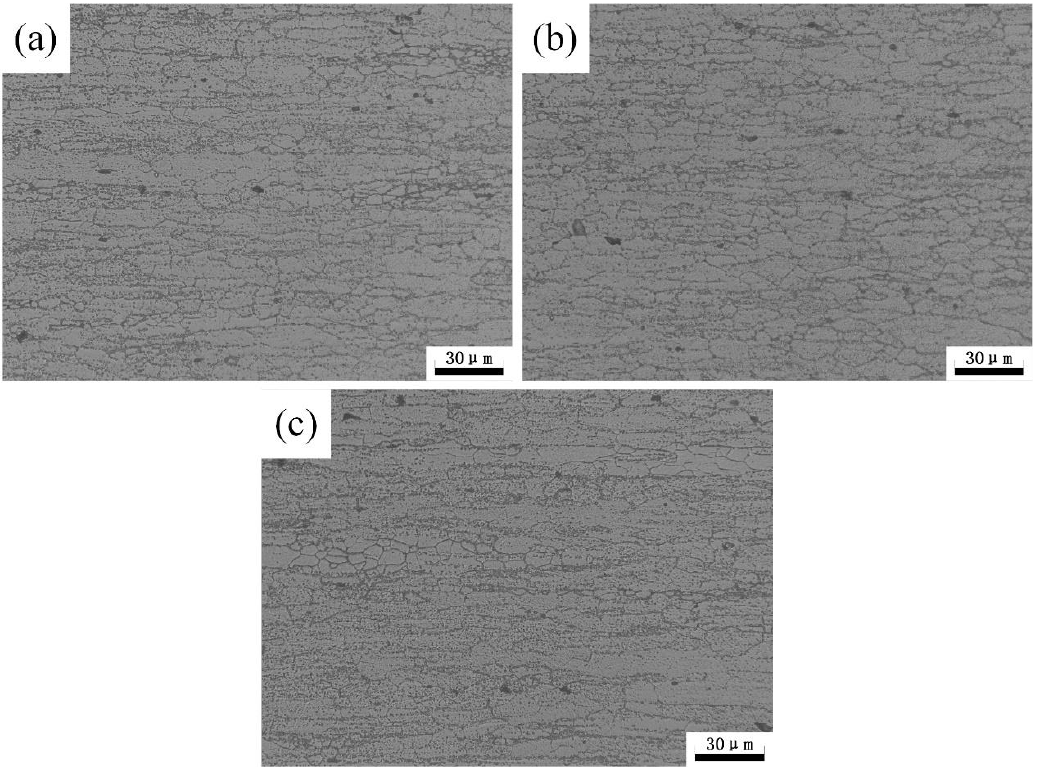
Figure 11. Metallographic structure of 7N01 aluminum alloy for ( a ) base metal; ( b ) 300 °C and ( c ) 350 °C.